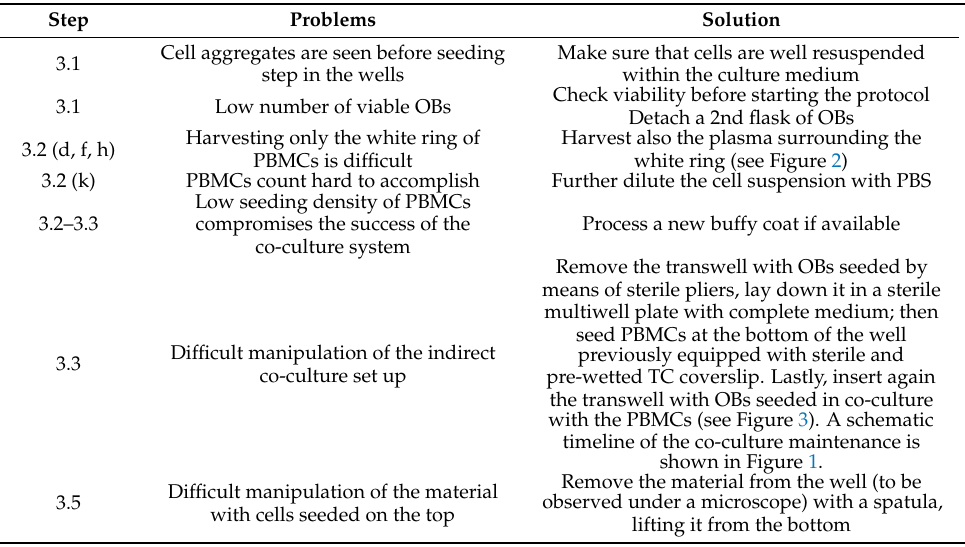
Table 2. Troubleshooting during the different steps of the